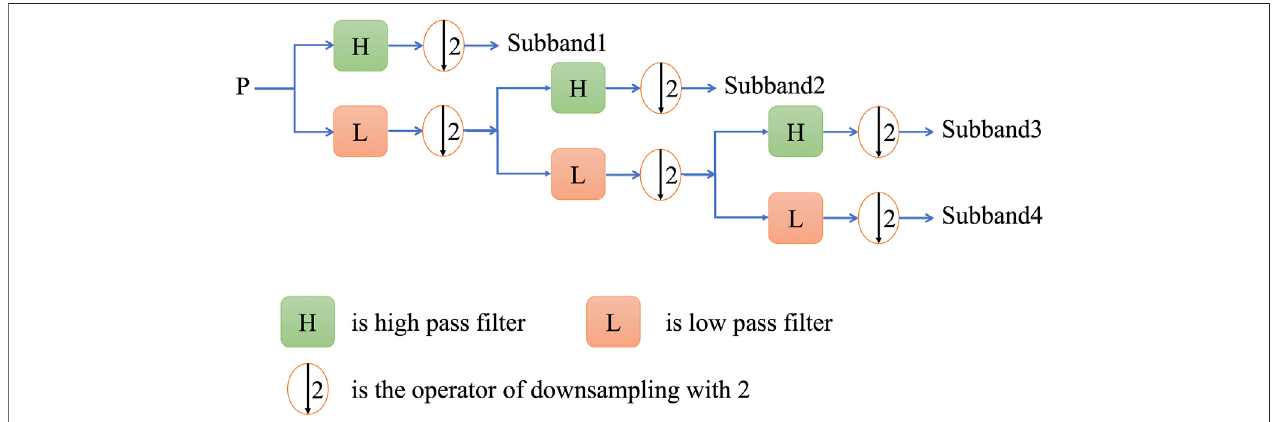
FIGURE 4 | A schematic drawing to illustrate the procedure of multi-level